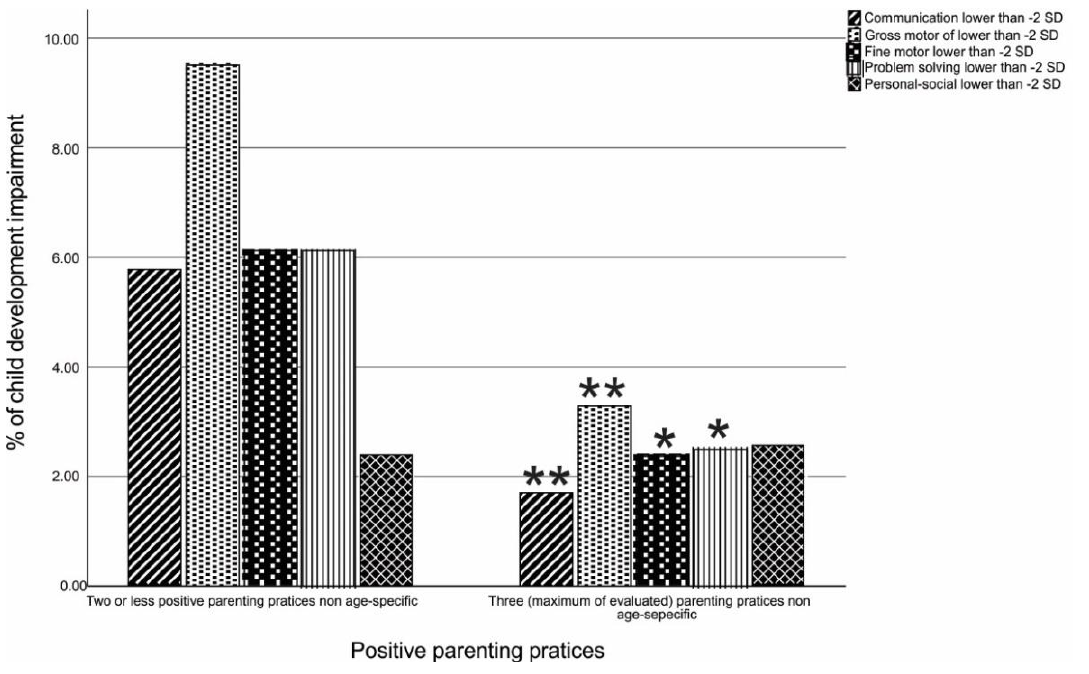
Figure 1. Percentage of children with developmental impairment in groups with all positive parenting behaviors present or not. * p -value = 0.001. ** p -value < 0.001.